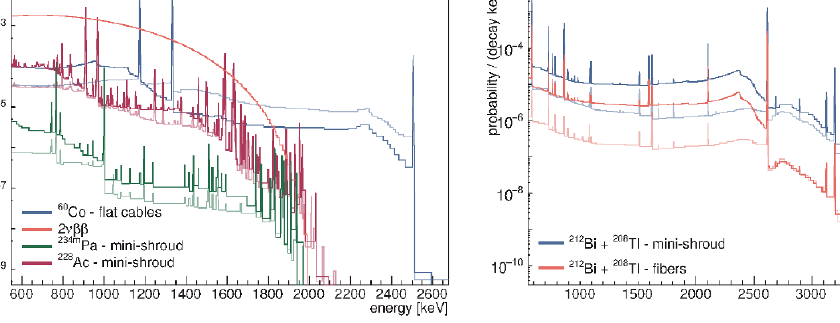
(a) 60 Co, 234m Pa, 228 Ac contaminations and de- tector intrinsic 2 (cid:23)(cid:12)(cid:12) decay.